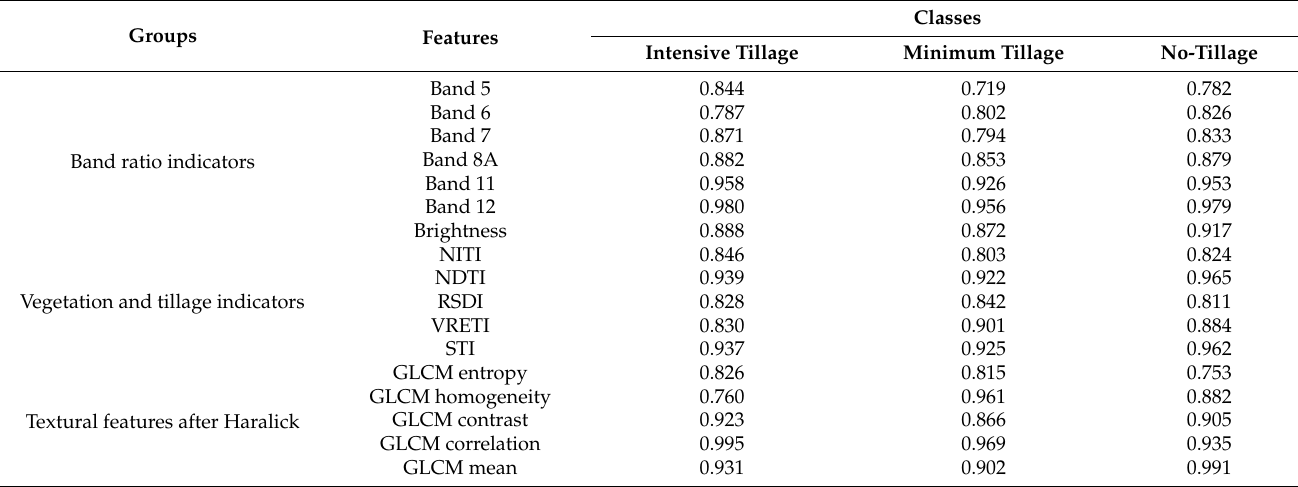
Table 4. Fuzzy numbers for different features about three classes of tillage intensity for multispectral Sentinel-2 satellite image.